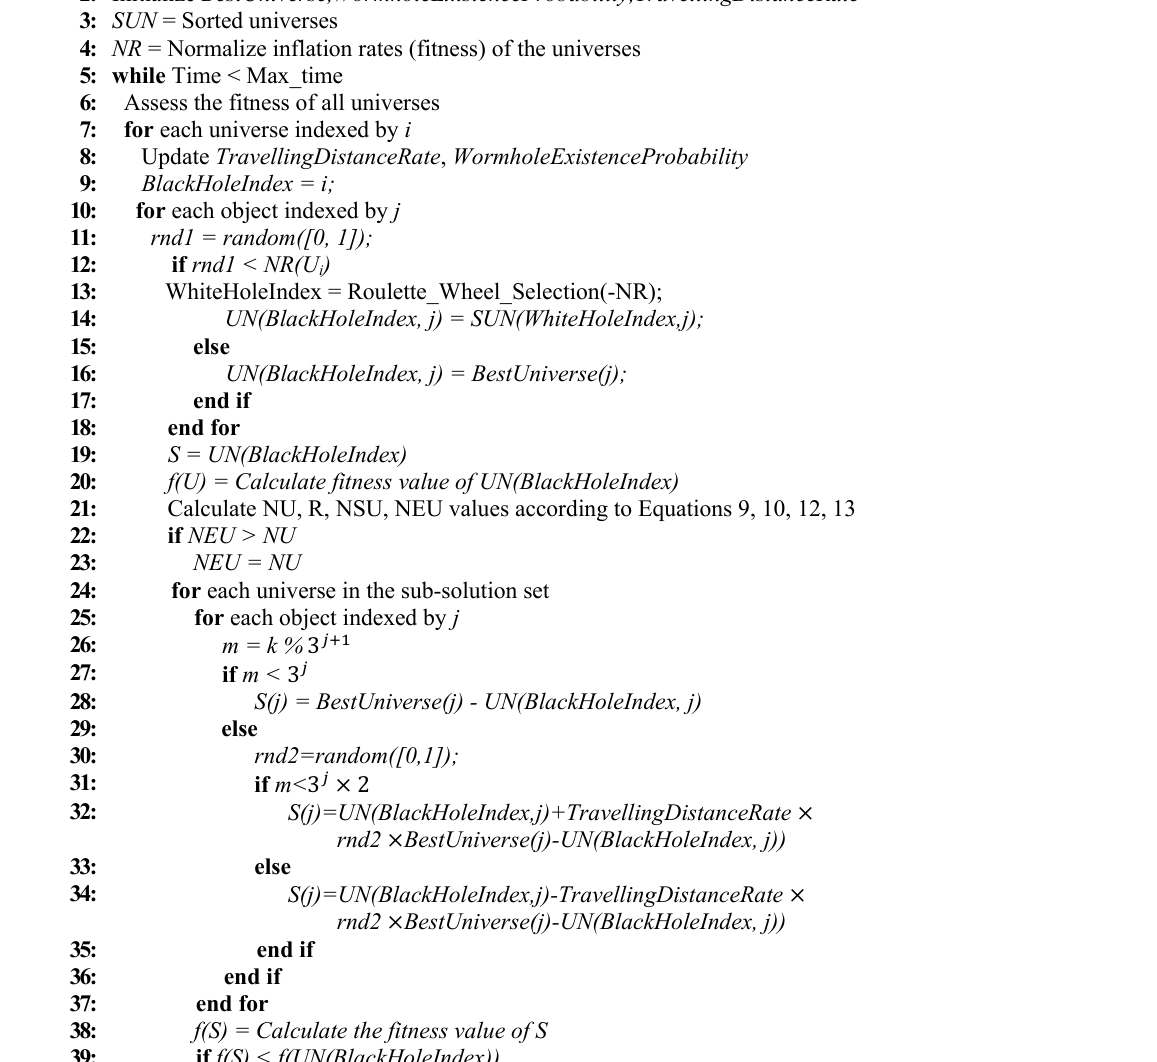
Algorithm 3. IMVOSA (continued